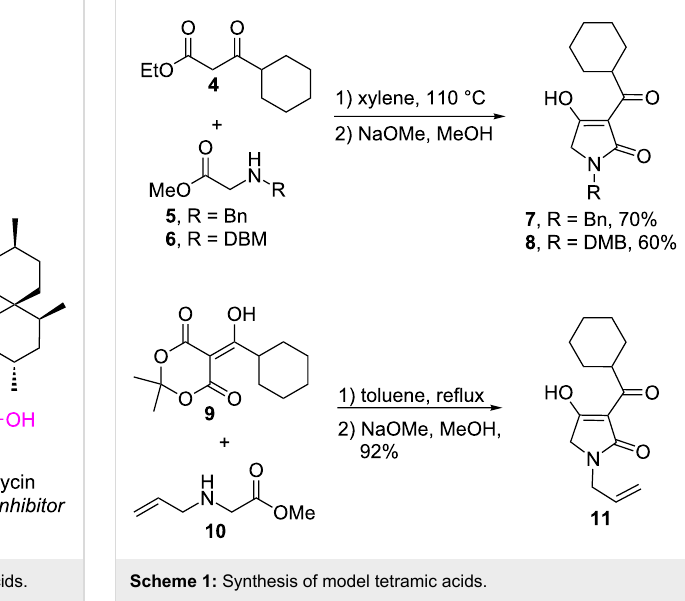
dine reagent 13 provided the desired product in 27% yield. Similar results were obtained when 3-phenyl-2-(phenyl- sulfonyl)oxaziridine ( 14 ) was employed, but product 15 from the concomitant reaction of bisenolate addition to N -sulfon- imine byproduct was also isolated in 15% yield from this reac- tion. Some peroxide-based electrophilic oxidants (Table 1, entries 3–5) were also briefly tested, but were found to produce rather mediocre yields of hydroxylated compounds. Attempted oxidations with Oxone or air gave no product at